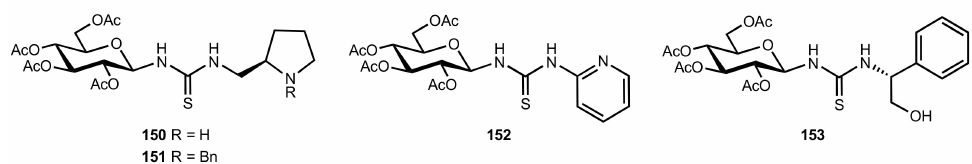
Figure 19. The structure of organocatalysts 150–153